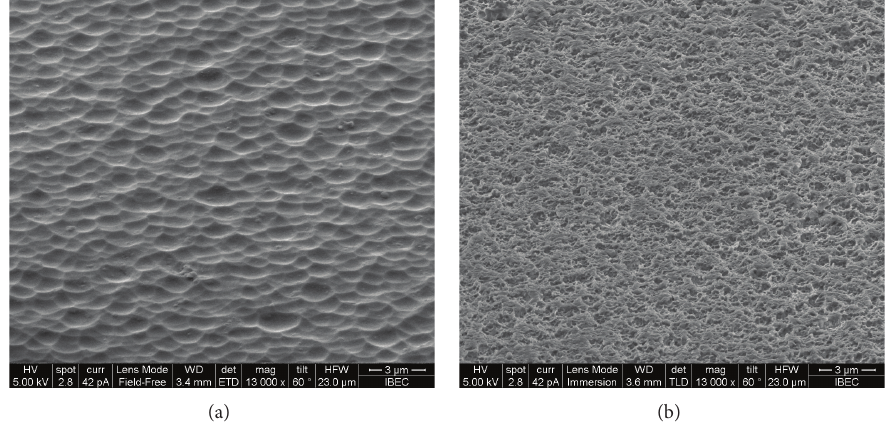
Figure 2: HRSEM micrographs (tilted at 60 ∘ ) of textured glass surfaces (a) texture E and (b) texture S.